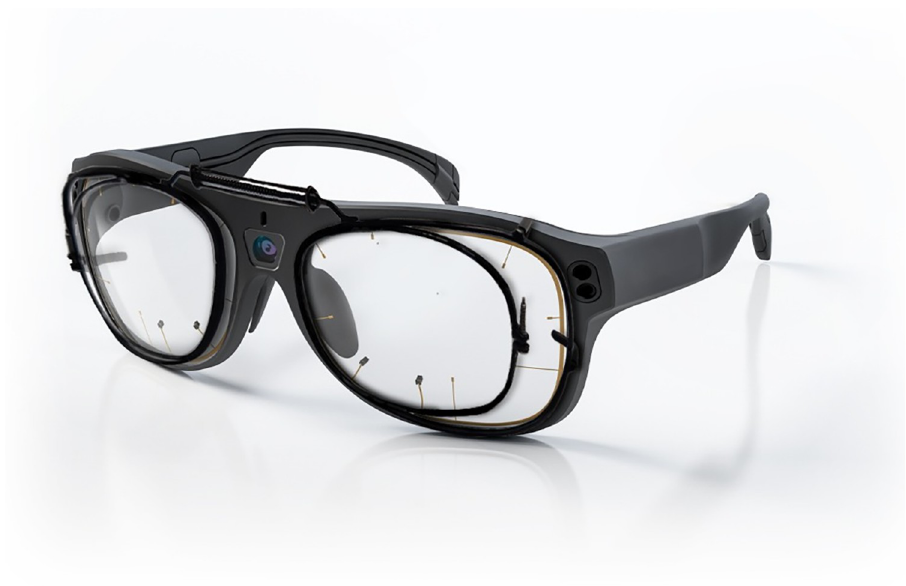
Fig 2. Picture of the metallic frame developed ad-hoc for this study attached to Tobii Glasses PRO 3.